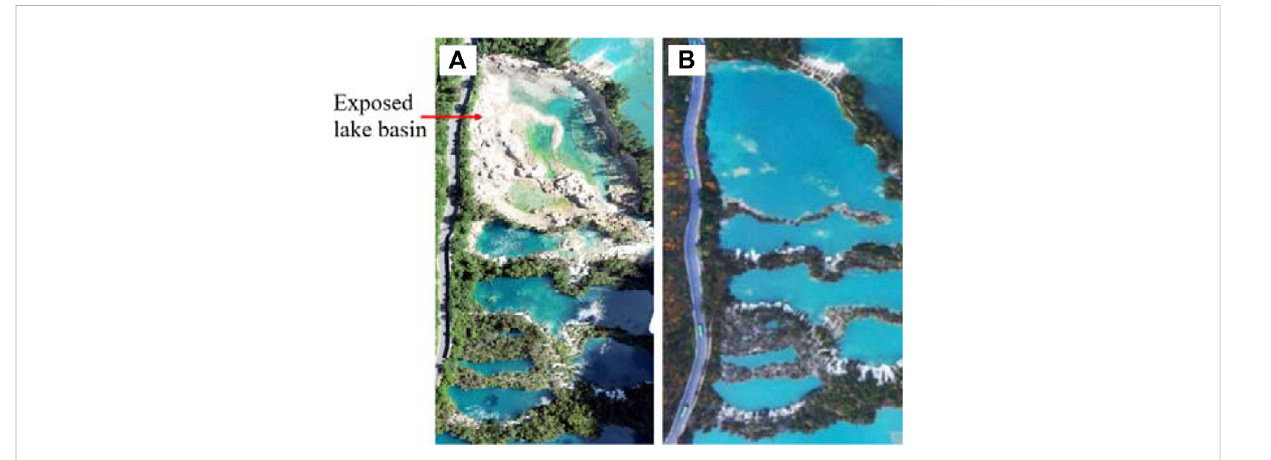
FIGURE 2 Sparkling Lake in the Jiuzhai World Natural Heritage Site after the 2017 earthquake (A) and restoration (B) . Note: photos were taken by unmanned aerial vehicles in 2020 and 2021.